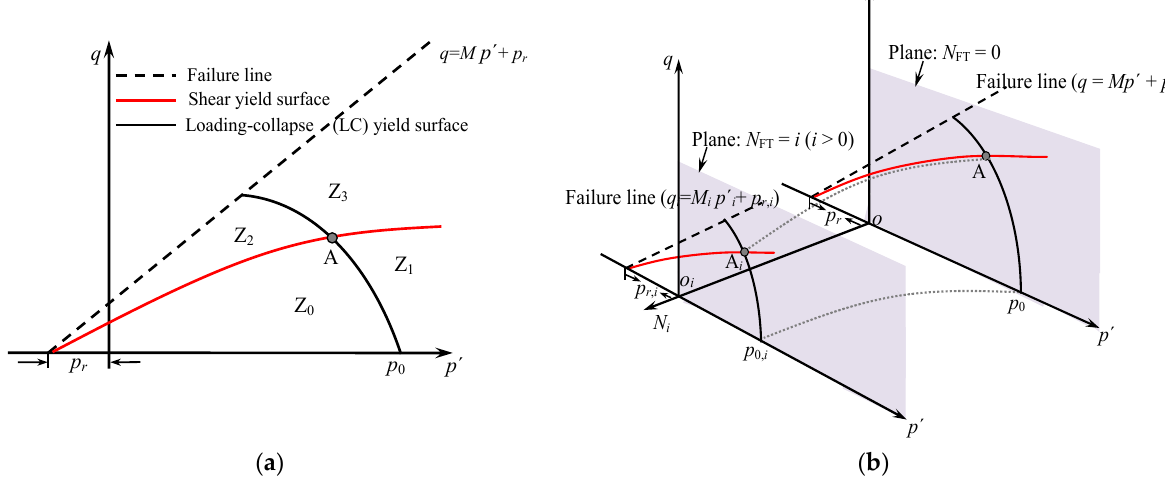
Figure 2. Yield surfaces in q - p ′ space: ( a ) Yin’s proposed yield surfaces (1988); ( b ) yield surfaces under freeze–thaw cycles.